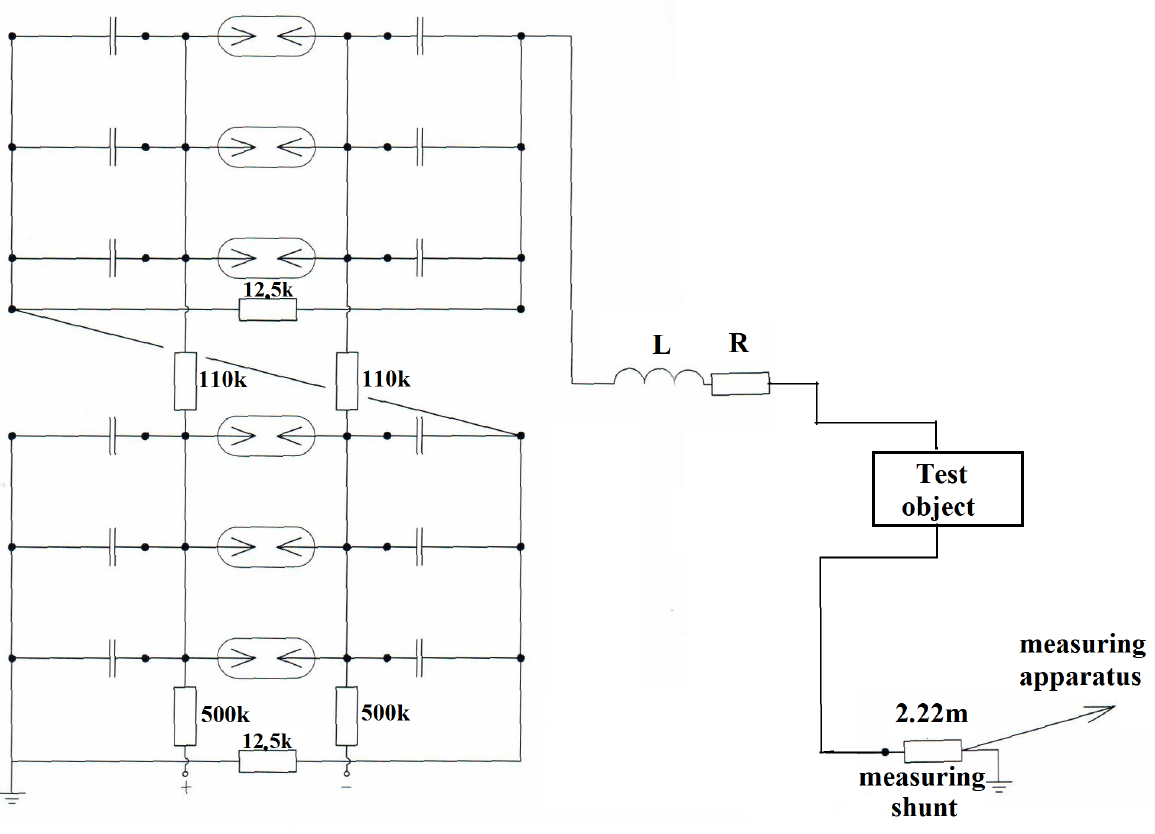
Figure 2. Schematic diagram of the generator used in the